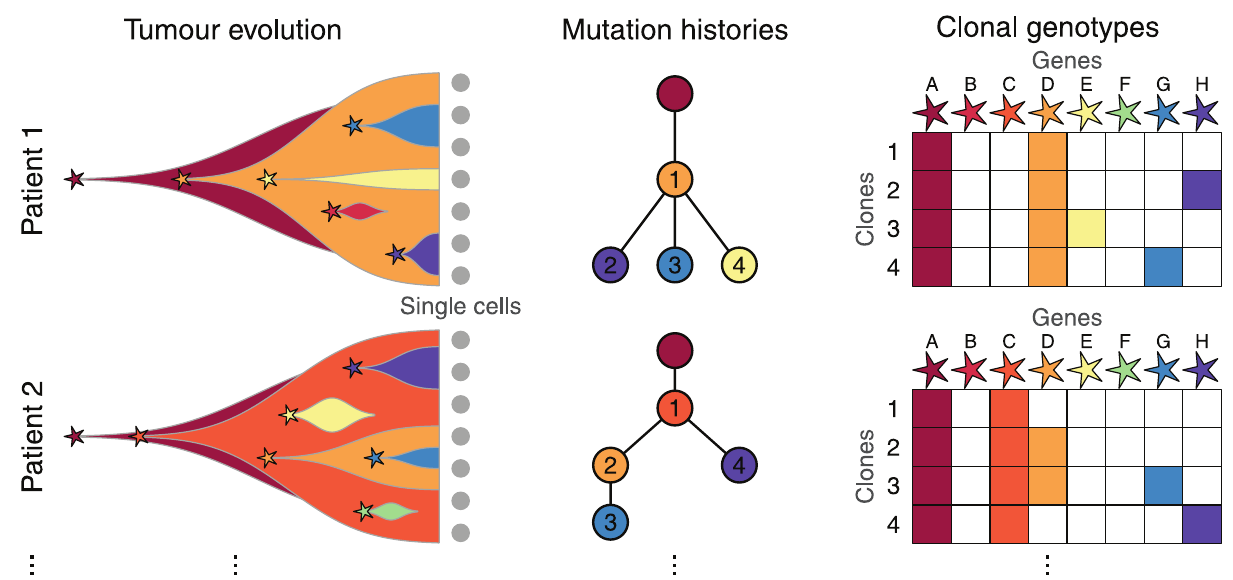
Fig 1. Tumour evolution and clonal exclusivity. During tumour evolution different mutations may arise leading to heterogeneous subclones with distinct genotypes. From single-cell sequencing we may reconstruct the mutational history of each tumour, encoding the ordering of mutations and their phylogenetic relationships. The clones are numbered in each tree and inherit mutations in ancestral clones. For example in patient 1, clone 2 exhibits mutations in genes A, D and H (red, orange, purple) as displayed in the clone-genotype matrix on the right. Clonally exclusive mutations will appear in different branches of the trees and exhibit mutually exclusive patterns in the clone-genotype matrices, as exhibited for example for the two rightmost mutations G and H (blue and purple) in both patients.